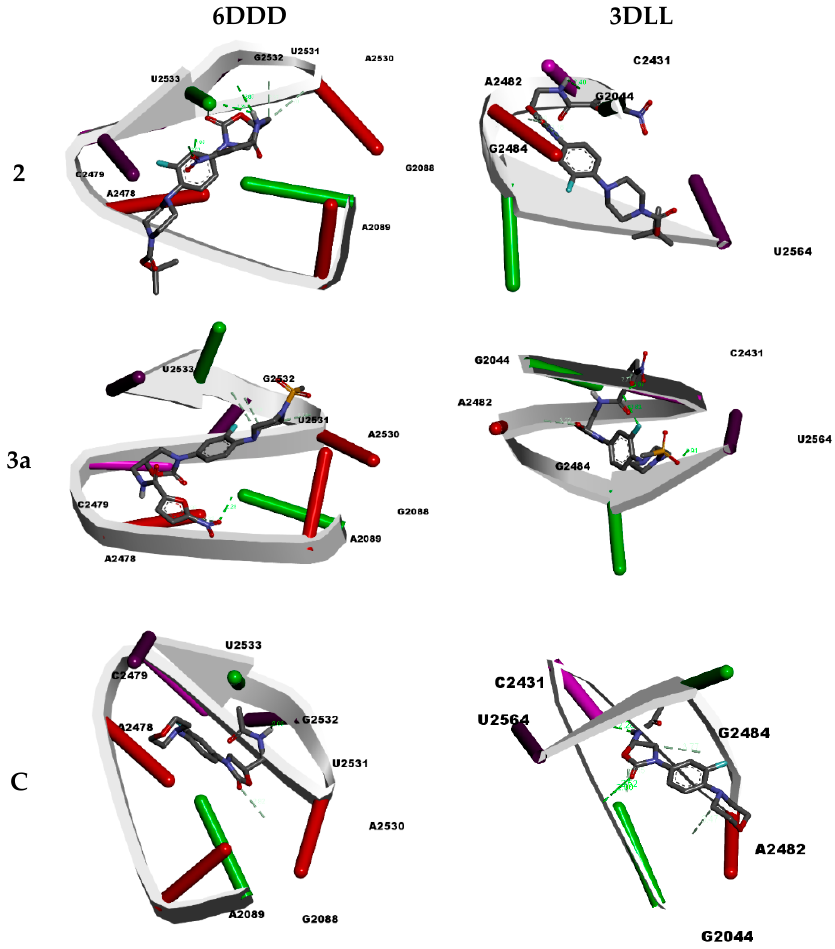
Figure 3. Binding interactions of the potent oxazolidinones ( 2 and 3a ) with 50S ribosomal units (6DDD), and the associated ribosomal peptidyl-transferase (3DLL). The control used was linezolid (C).